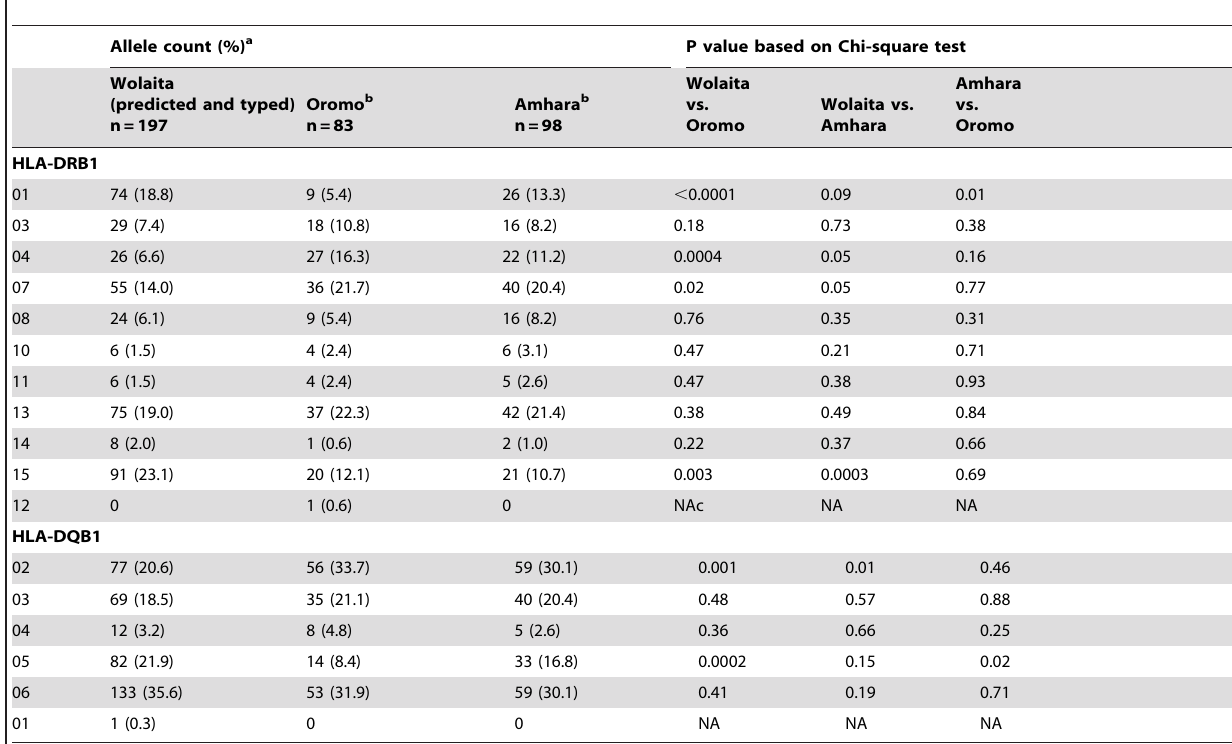
Table 4. Distribution of HLA-DRB1 and HLA-DQB1 alleles in the Wolaita, and comparison of their frequencies with the Ethiopian Oromo and Amhara ethnic groups.